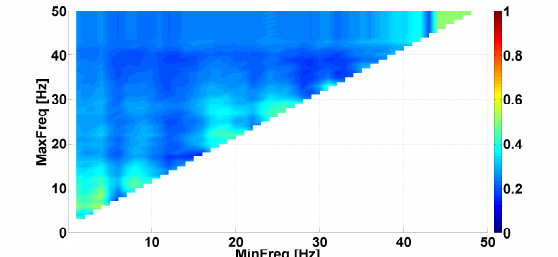
Figure 18. Example of Frequency CWS AUC diagram. The instantaneous phase of the considered cross-wave trains is constrained by the ranges from − π to − π /2 and from + π /2 to + π . Signals from the antagonist muscles in the right arm with hyperkinetic movement in PD and ET patients are considered. The abscissa axis is the lower bound of the frequency range; the ordinate axis is the upper bound of the frequency